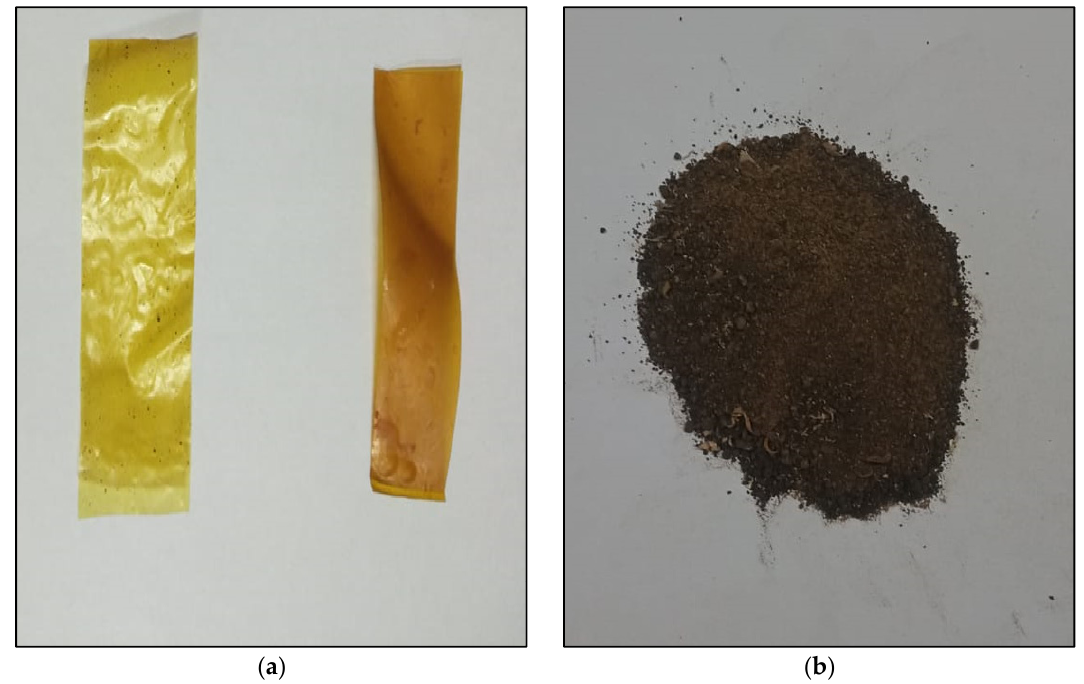
Figure 4. The result of biofilm samples ( a ) before the bioplastic thermal resistance test, ( b ) after the bioplastic thermal resistance test.